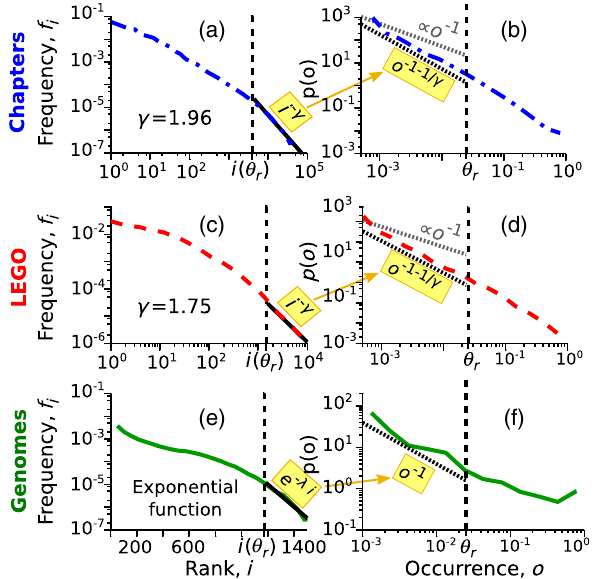
FIG. 6. The relation between the exponents of frequency rank plot and occurrence distribution is satisfied in all the three data sets. The plots consider the low occurrence region, below the arbitrary threshold θ r ¼ 0 . 025 , which corresponds to the high- rank region above i ð θ r Þ in the frequency rank plot (see main text). Panels (a) and (b) refer to book chapters, for which the tail of rank plot is a power law with exponent γ ¼ 1 . 96 , which implies a power-law decay of p ð o Þ with exponent 1 þ ð 1 = γ Þ ¼ 1 . 51 . Panels (c) and (d) show the LEGO data set ( γ ¼ 2 . 8 , 1 þ ð 1 = γ Þ ¼ 1 . 36 ). Panels (e) and (f) correspond to protein domains in genomes, where the best fit of the tail region is an exponential function [note that (e) is in linear-logarithmic scale], which implies a power-law decay with exponent − 1